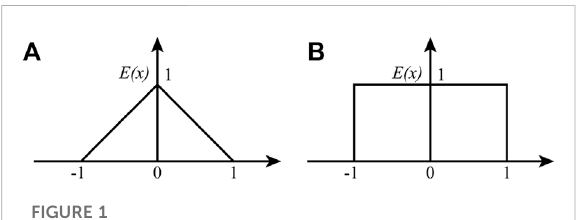
FIGURE 1 Fuzzy structured element. (A) Triangle structured element; (B) Rectangle structured